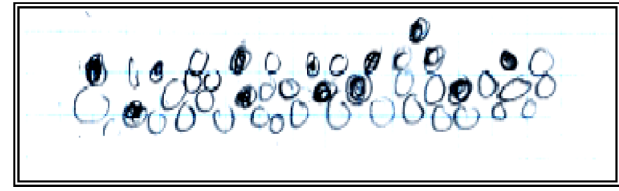
FIG. 5 (color online). The atoms of the wooden block (shaded) interlock with the atoms of the tabletop (not